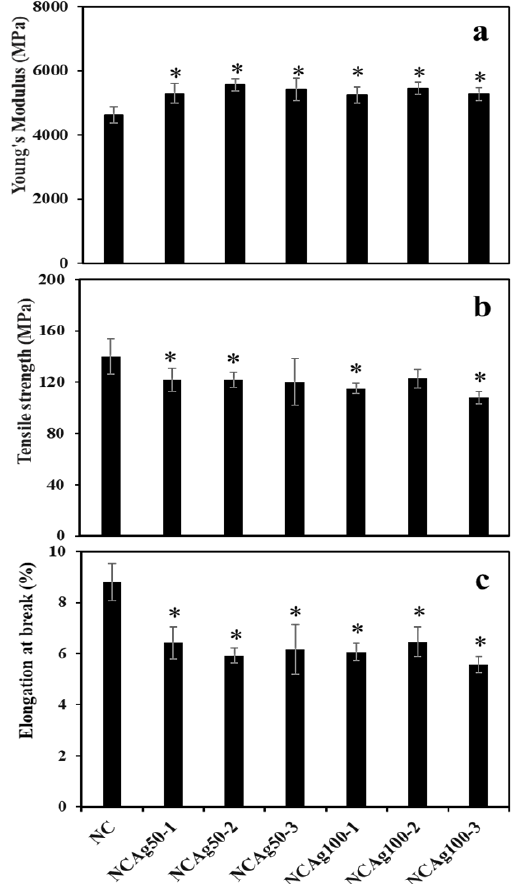
Figure 6. Young’s modulus ( a ), tensile strength ( b ), and elongation at break ( c ) of NC and NCAg composite films. The symbol * indicated a significant difference ( p < 0.05, n = 5) vs. NC film.